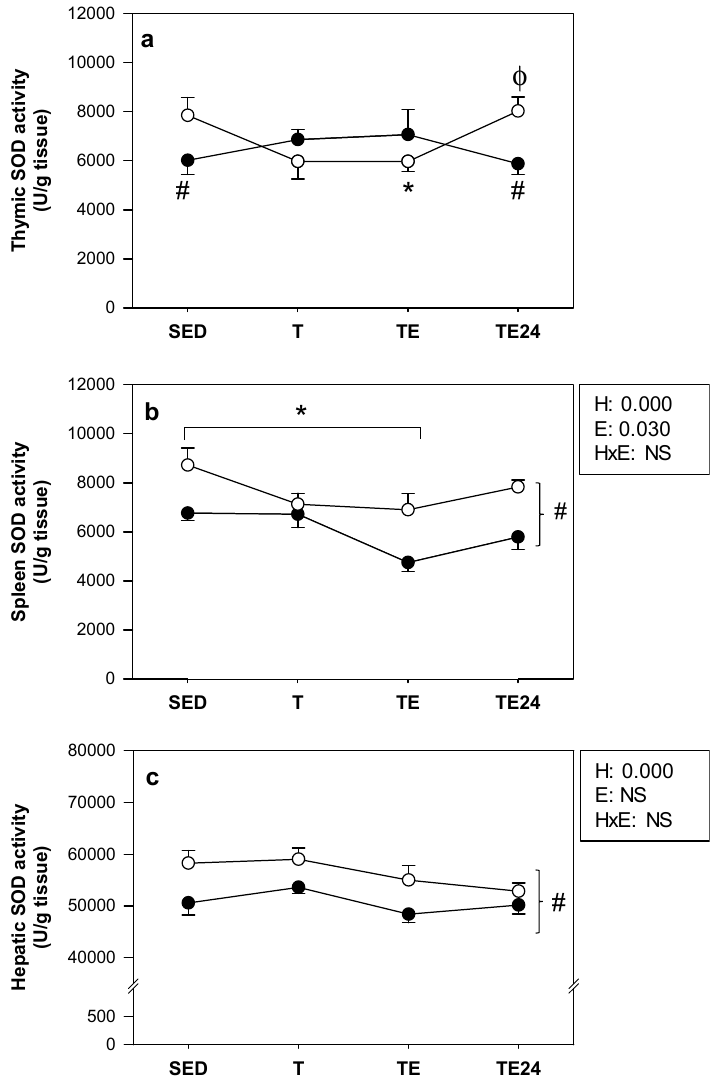
Figure 5. Superoxide dismutase (SOD) activity in the thymus ( a ), spleen ( b ) and liver ( c ) at the end of the study. The non-supplemented groups are represented by white symbols ( ⚪ ) and the hesperidin groups by black symbols ( ⚫ ). SED = sedentary group, T = trained group, TE = T group with an additional exhaustion test, TE24 = TE group 24 h after the exhaustion test, NS = no statistically significant differences detected. Data are expressed as mean ± SEM ( n = 7–8). Statistical difference in ( a ) (Mann–Whitney U test): # p < 0.05 between non-supplemented and the hesperidin-supplemented groups; * p < 0.05 vs. SED group just in the non-supplemented animals; φ p < 0.05 vs. T group just in non-supplemented animals. Statistical difference in ( b , c ): the inset table shows two-way ANOVA results when applied (H, hesperidin; E, exercise; HxE, interaction between hesperidin and exercise); # p < 0.05 between non-supplemented and the hesperidin-supplemented groups; * p < 0.05 exercise vs exercise conditions.